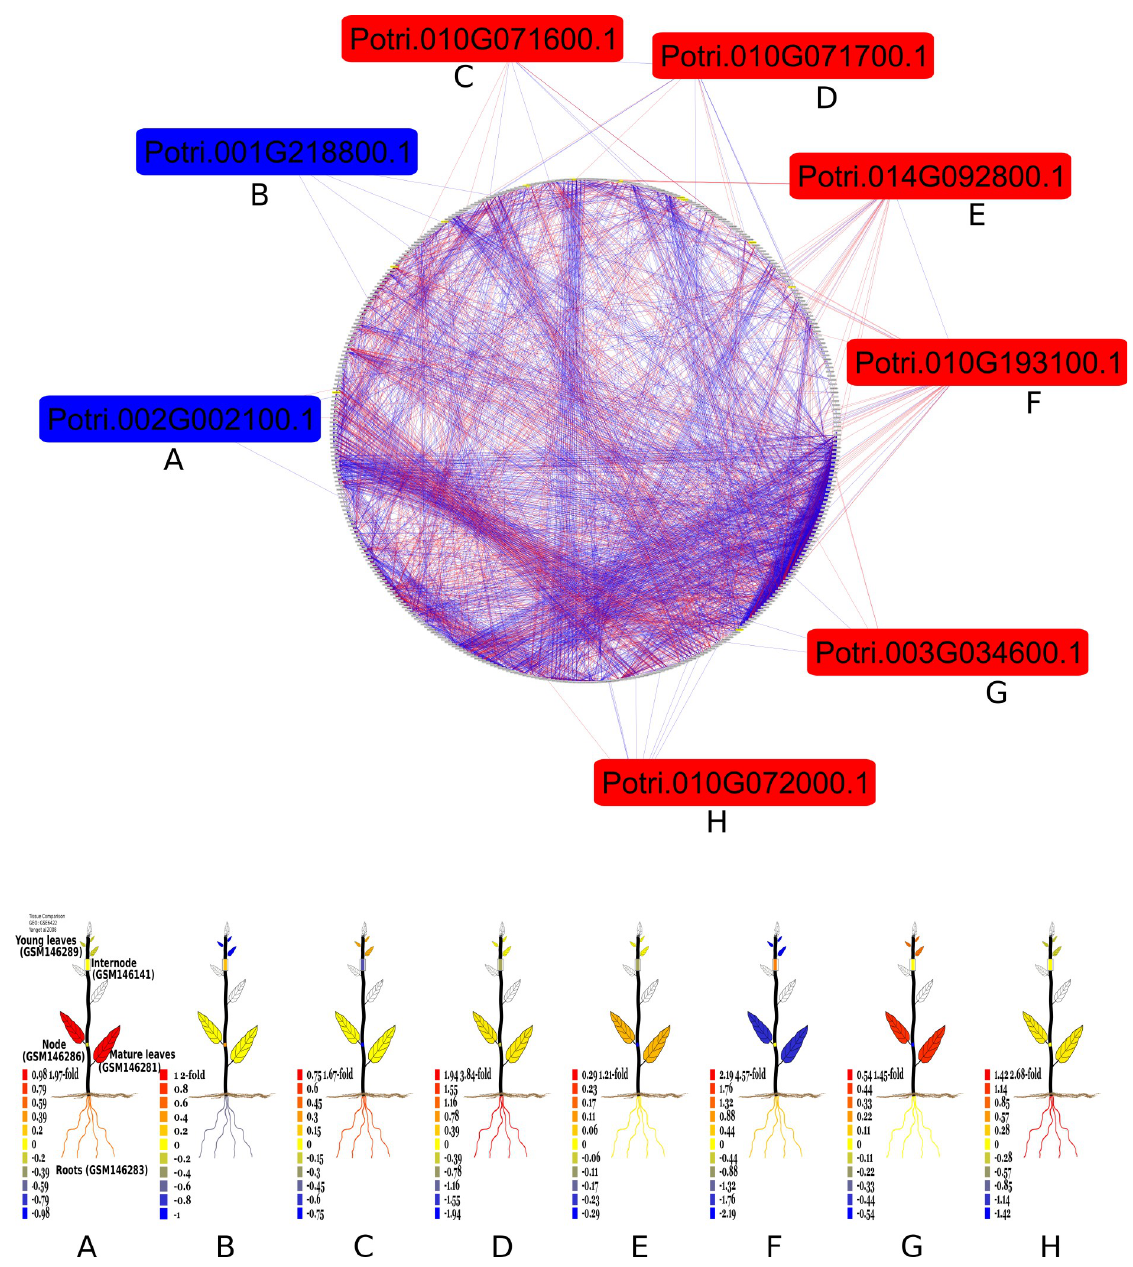
Fig 6. Co-expression network between genes with the same transcriptional regulation profile for aluminium toxicity and phosphate deficiency. Green rectangles refer to the activated genes and red rectangles to genes inhibited by both stresses; grey rectangles at the edge of the circle refer to genes with constant expression between the two stresses (variation below 20%). Blue lines refer to positive correlations and red lines to negative correlations, with p � 0 . 8 .